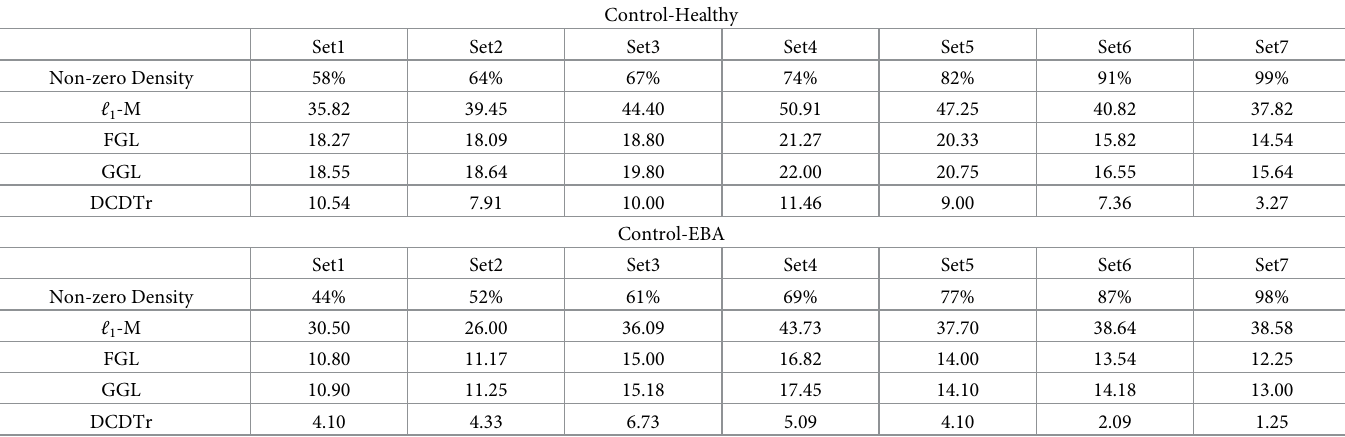
Table 10. The nonzero density and average degree for each set and networks constructed by various methods in Control-Healthy and Control-EBA